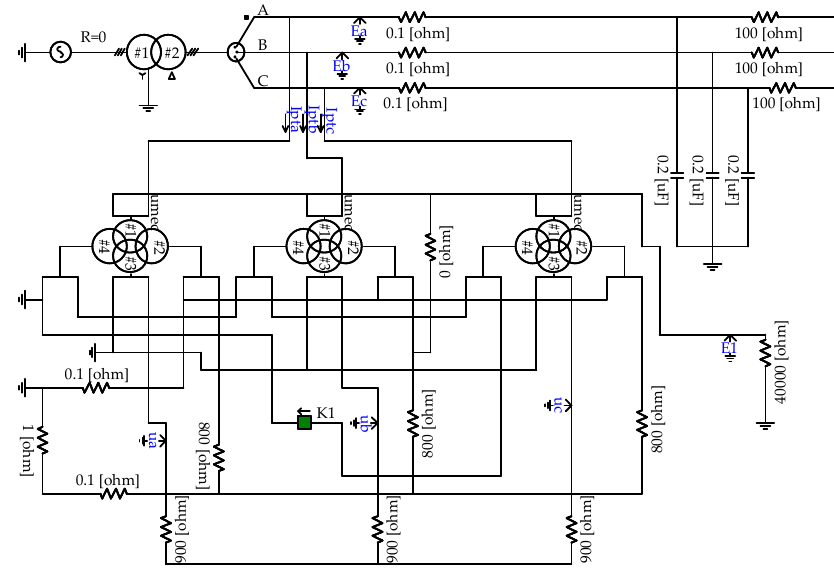
Figure 8. PSCAD simulation model.